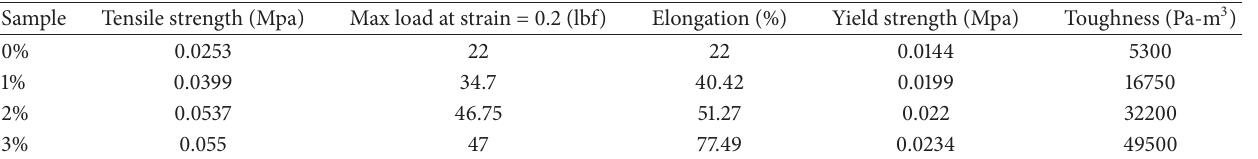
Table 2: Tensile properties.